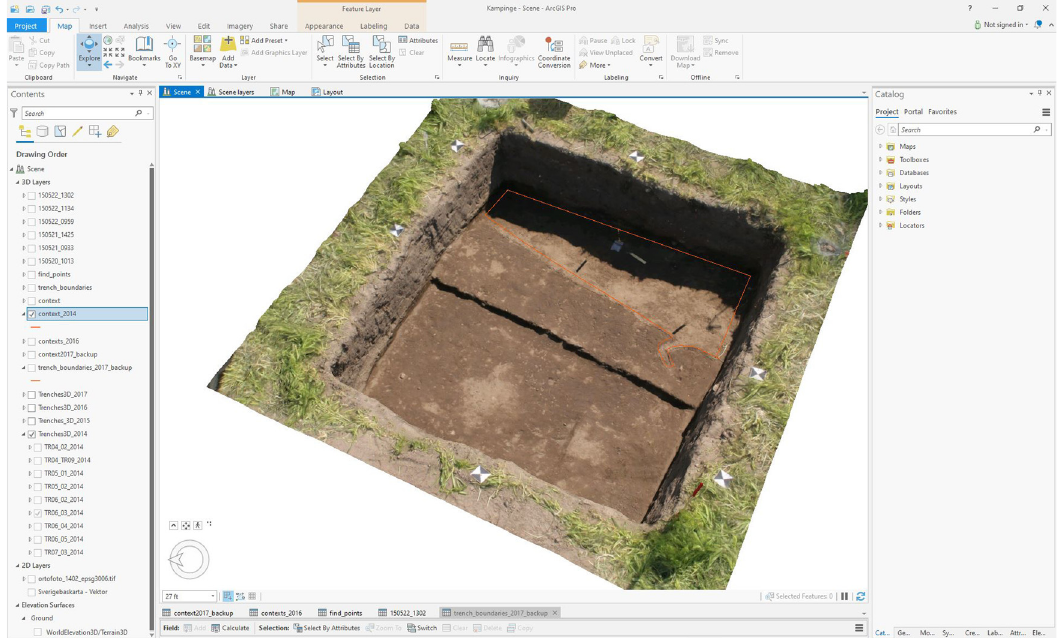
Figure 5: 3D models of trench 6 excavated during the excavation campaign 2014. The model was implemented in the 3D GIS during postexcavation activities. The shape fi les ( in orange ) were created using RTK di ff erential GPS and superimposed directly on the model. The polylines created with the RTK GPS do not allow a proper geometrical description of complex shapes and cannot be veri fi ed in the fi